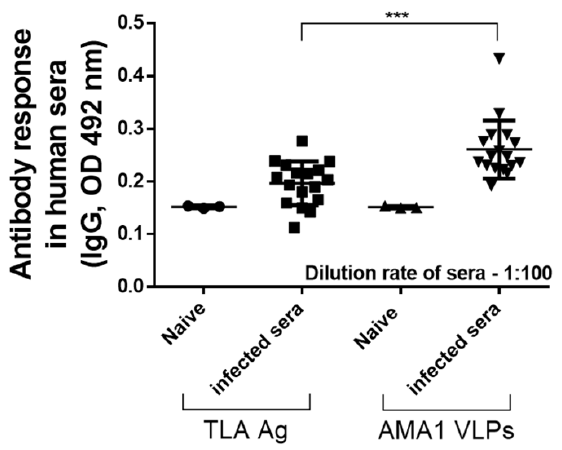
Figure 7. Reactivity of AMA1 VLPs antigen to T. gondii -infected human sera. To validate the serological findings observed from mice, human sera were acquired from toxoplasmosis patients. Toxoplasmosis-positive human serum IgG responses against TLA and AMA1 VLPs were compared to those of uninfected human sera. Data are presented as mean ± SD and are representative of the three individual experiments performed in triplicate (*** p < 0.001 vs. TLA). Table 1. Sensitivity and specificity of ELISA.